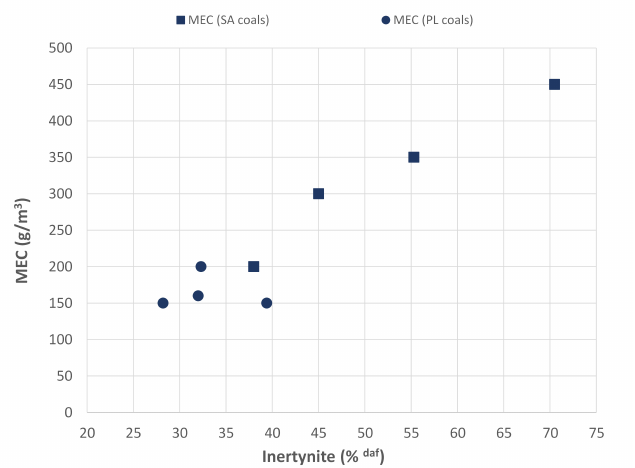
Figure 8. Variation in the Minimum Explosible Dust Concentration (MEC) with the maximum devolatilization reaction rate R max . vol .